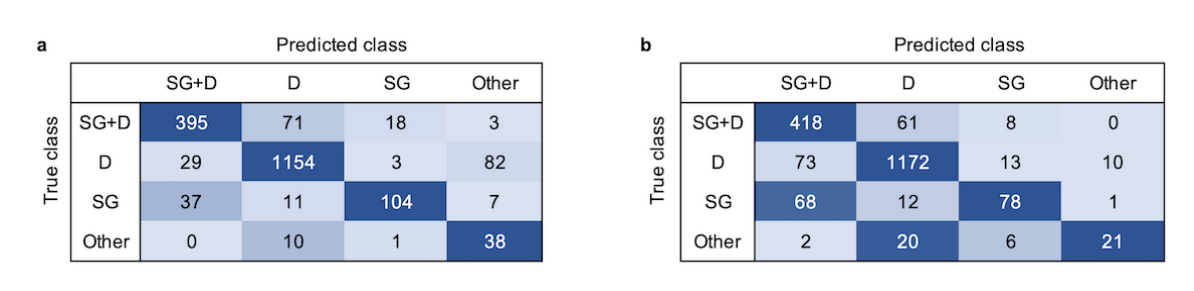
SupportHuman coderClassifierClasses